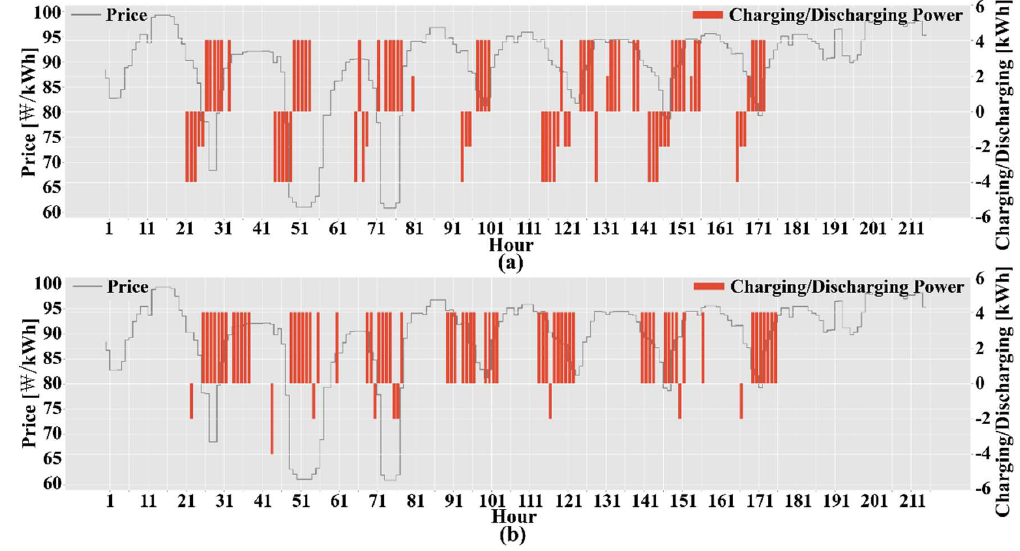
Figure 10. Scheduling results for several days; ( a ) site A ( b ) site B. 430